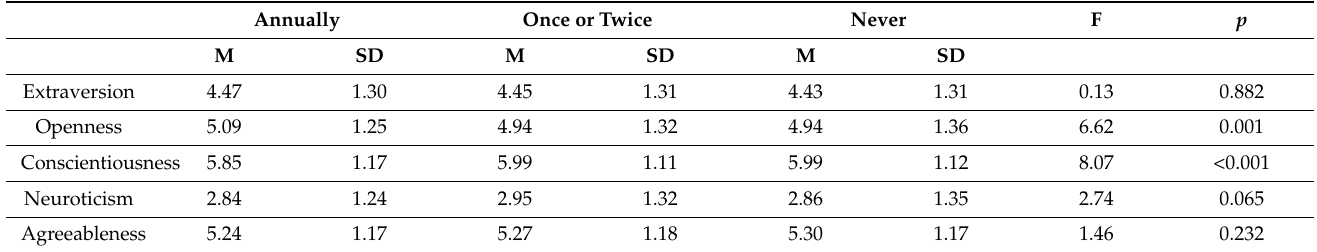
Table 5. Relationship between past Flu vaccination attitudes and Big Five personality